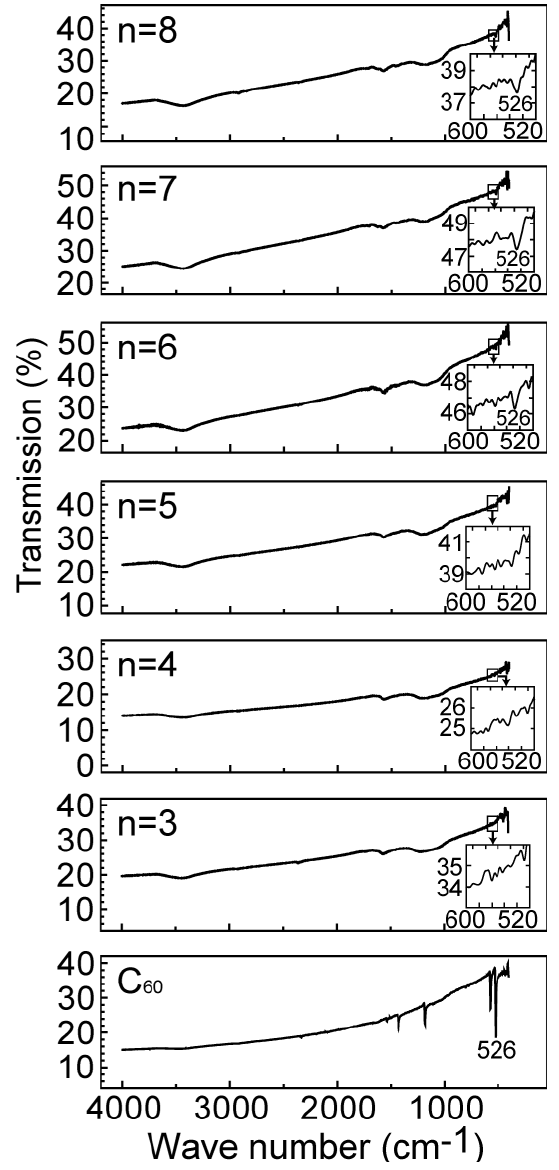
Figure 4. FT-IR spectra for the specimens of Figure 2. The C ( F ) modes are indicated by the inset of each panel of the 1u